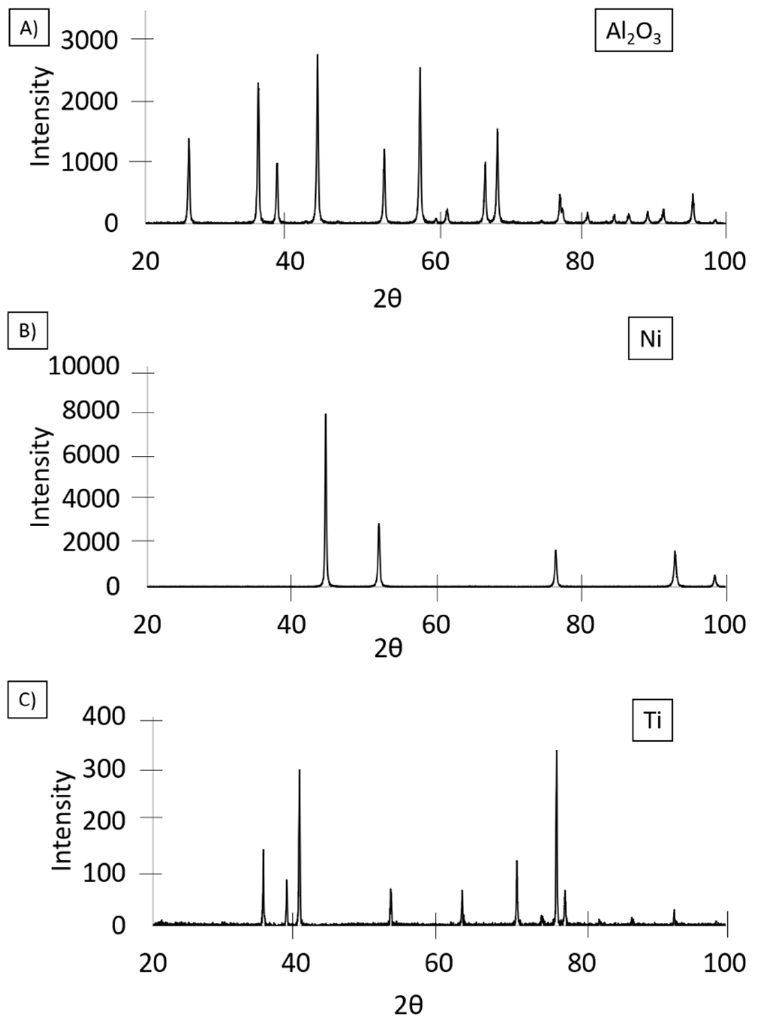
Figure 3. X-ray diffractograms of ( A ) alumina powder, ( B ) nickel powder, and ( C ) titanium pow- der.